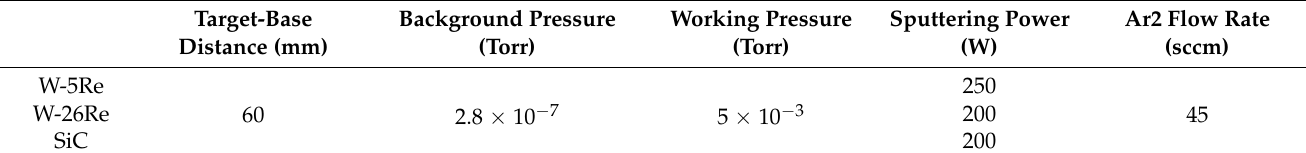
Table 1. Sputtering parameters.